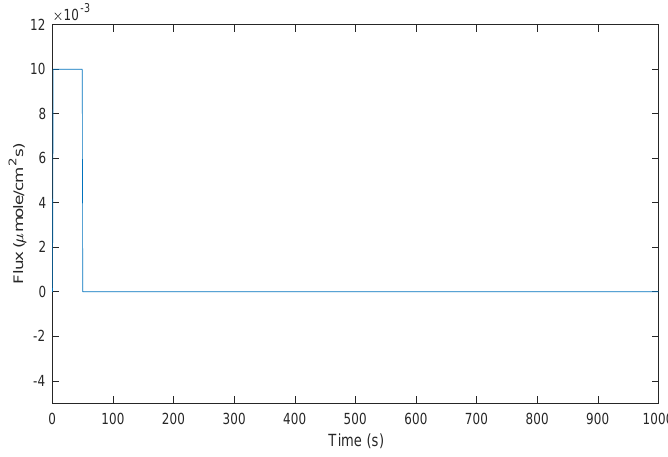
Figure 9. 50 s flux and 950 s rest applied to the surface of the particle. Energies 2018 , 11 , x FOR PEER REVIEW